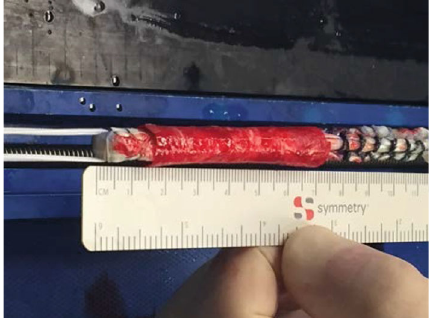
Figure 2: The soft tissue graft is tensioned on a standard prep board. The PRP-soaked TenoMend ™ is sutured around the graft, ensuring coverage of the graft contained within the bone tunnels as well as the joint.